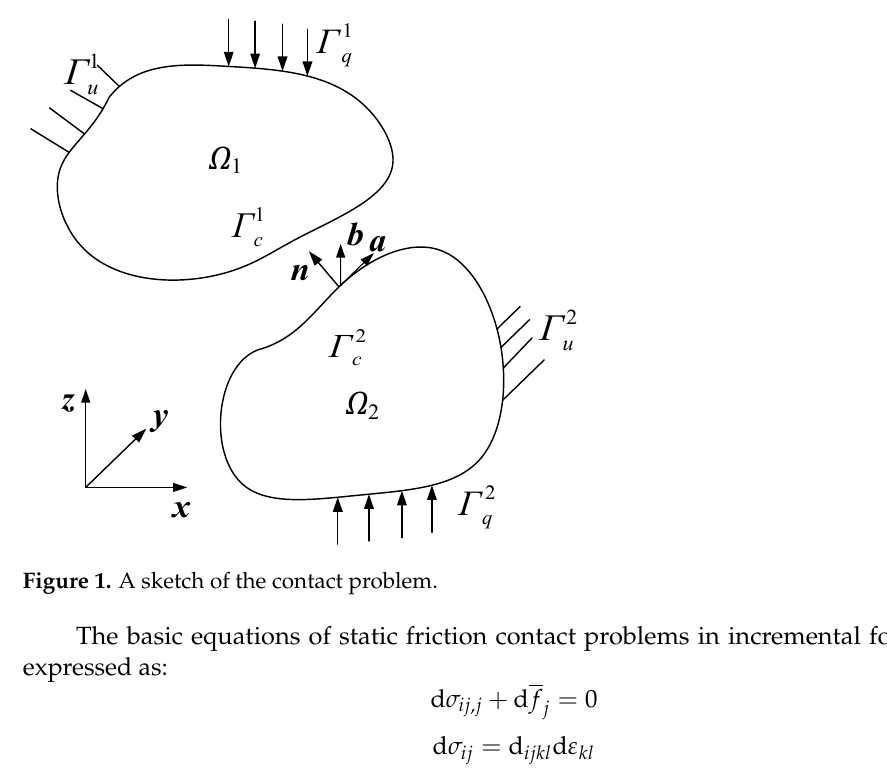
with the Neumann and Dirichlet boundary conditions: